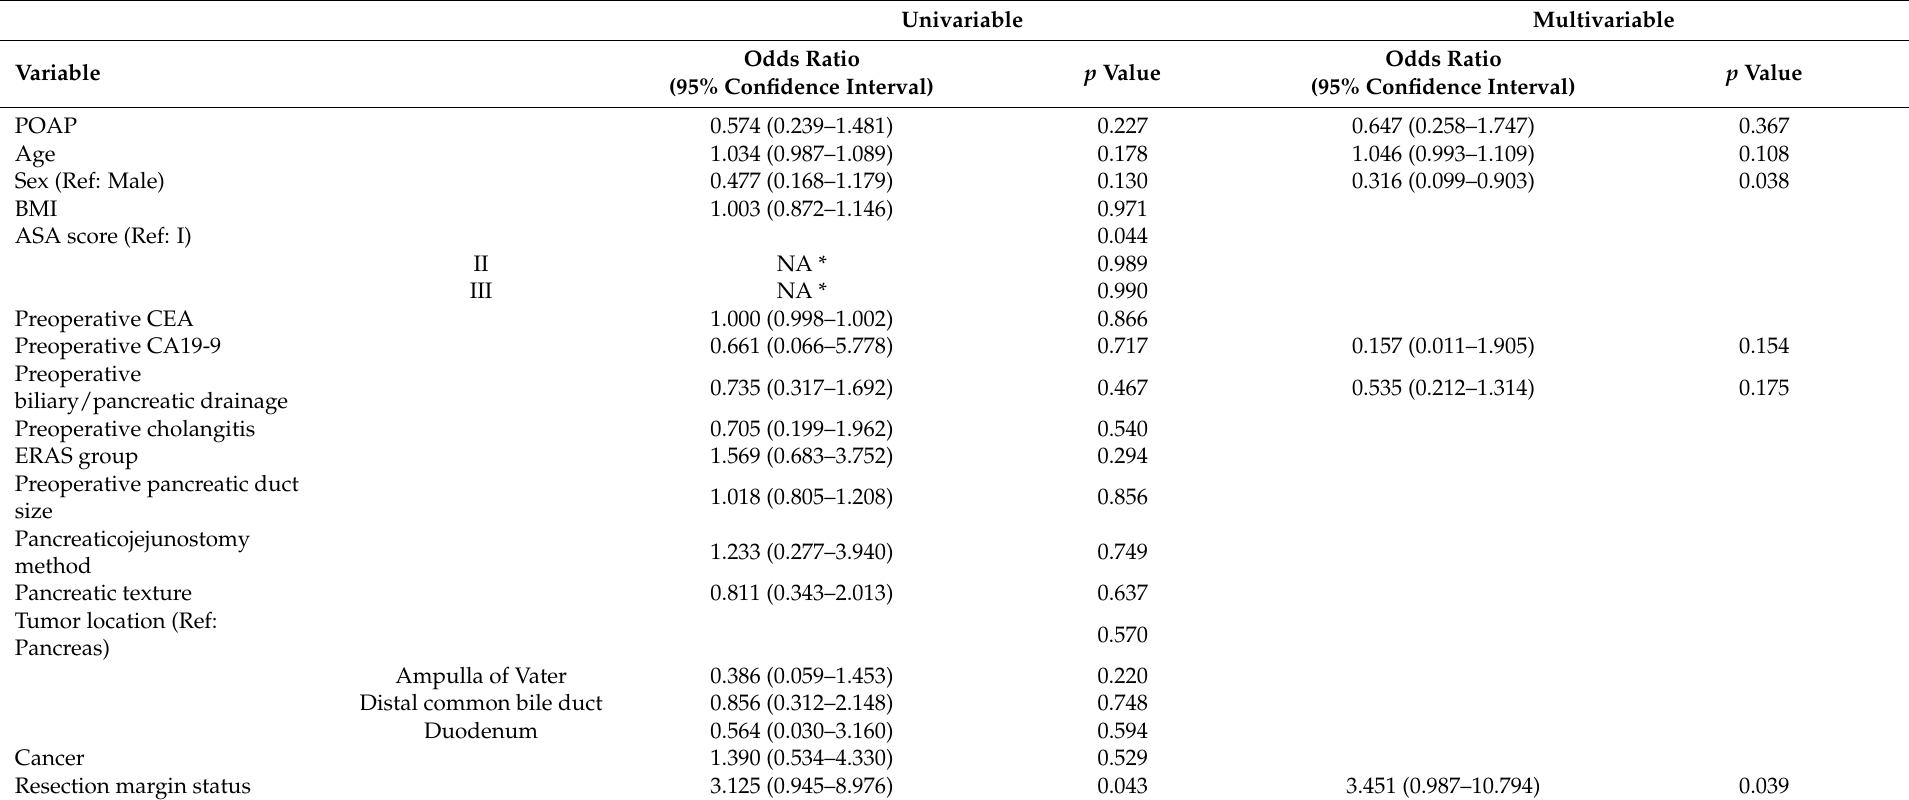
Table 4. Univariable and multivariable analyses of severe complications (Clavien–Dindo ≥ IIIa) after backward elimination by forcing the inclusion of POAP. Univariable